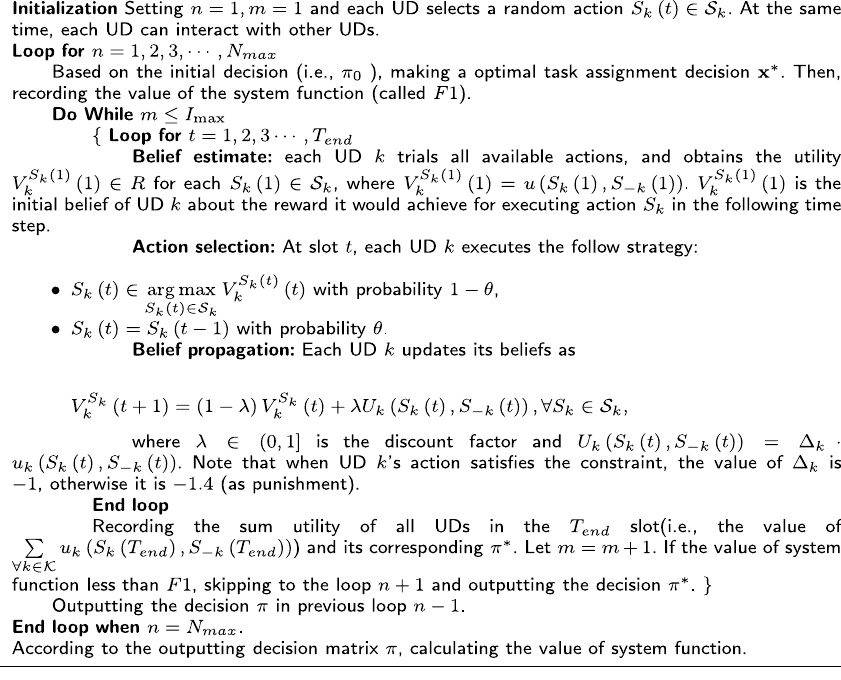
FM-JSFP algorithm. In summary, the time complexity of Algorithm 1 in the worst case is: